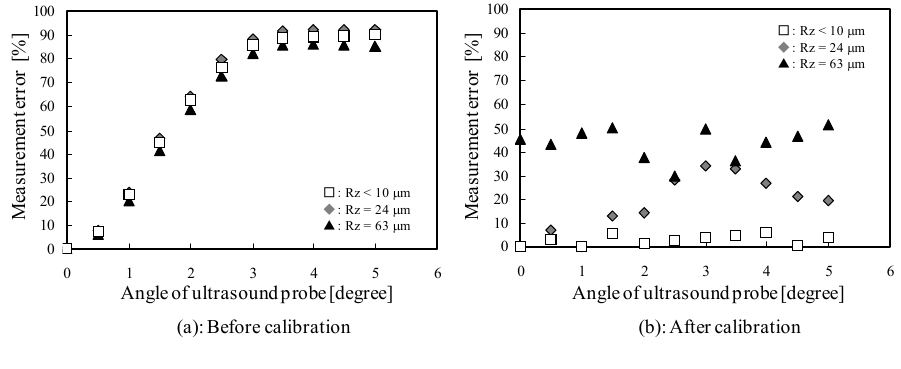
Figure 12: Relationship between measurement error and probe angle. The acrylic plates (Rz < 10 µ m, Rz = 24 µ m, 63 µ m) were used as reflection surfaces. (a): Before calibration. (b): After calibration. Mean values are shown for 0.0-5.0